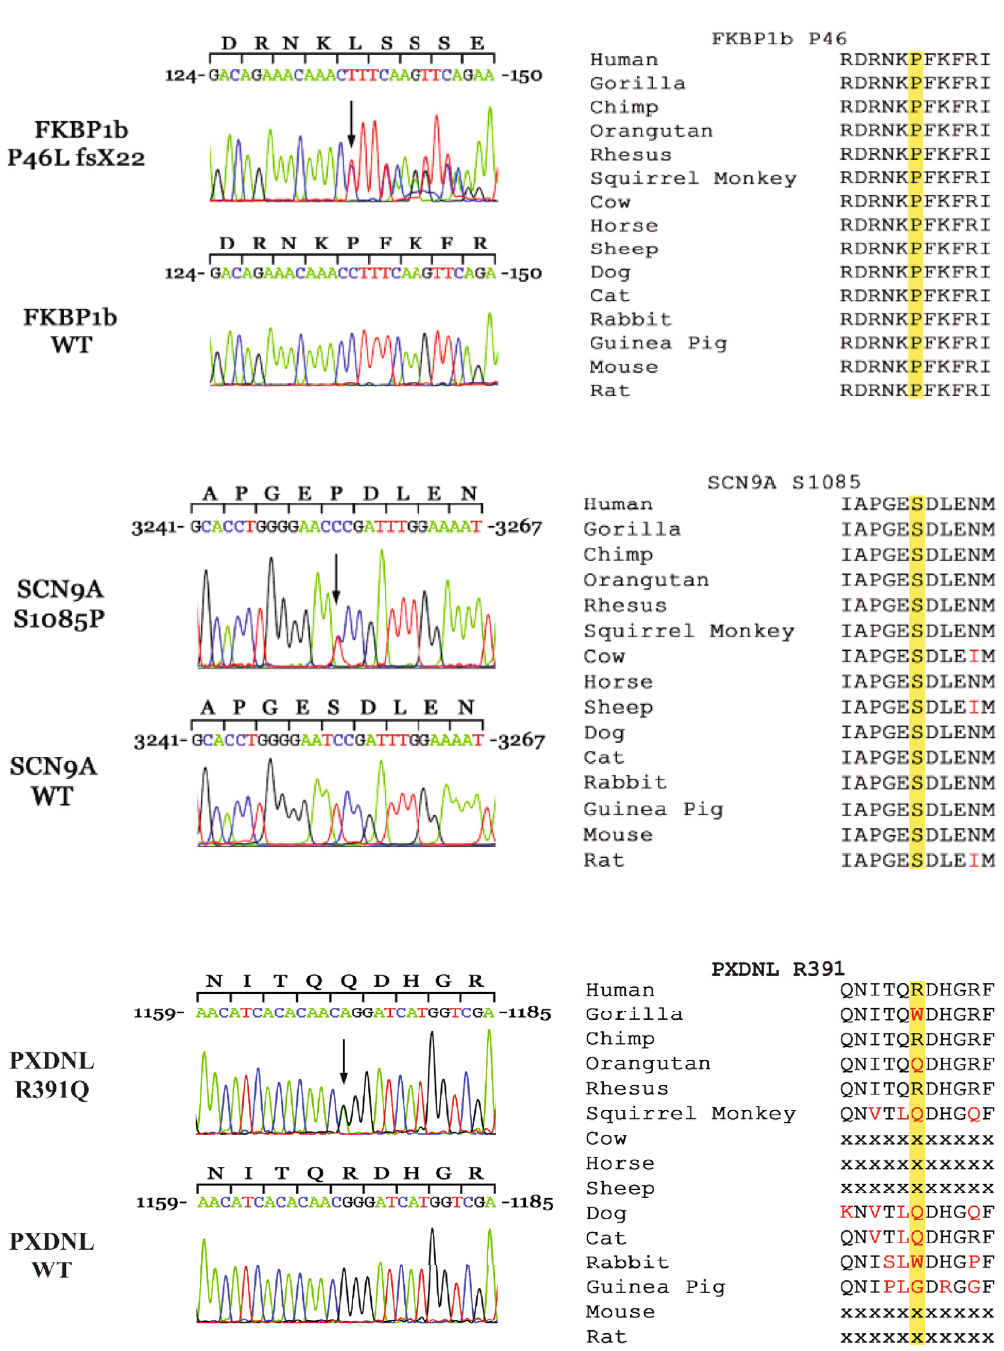
Figure 2: DNA sequencing analysis of SCN9A and FKBP1b. The FKBP1b gene was mutated to a C deletion at location 137 in exon 3 resulting in complexed amino acid changes. The amino acid change was proline to leucine at position 46; the next 22 amino acids were framed shifted culminating in a stop codon 22 amino acides downstream (P46L fsx22). The SCN9A gene was mutated from a T to C substitution at position 3253 in exon 17, resulting in an amino acid change from serine to proline at position 1085 (S1085P). The PXDNL gene was mutated from a G to A at position 1172 in exon 14, resulting in an amino acid change from arginine to glutamine at position 391 (R391Q). Mutations in SCN9A and FKBP1b are highly conserved across the various species. PXDNL is only expressed in certain mammals including